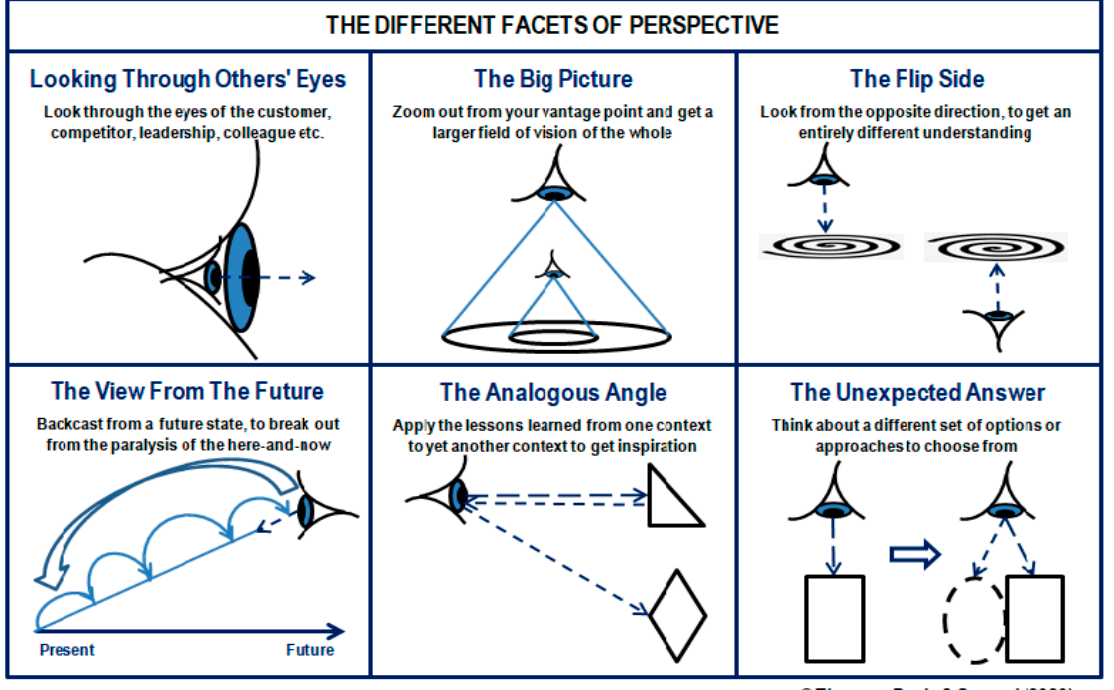
Figure 9. The Different Facets of Perspective, Illustrated. Figure 9. The Di ff erent Facets of Perspective,